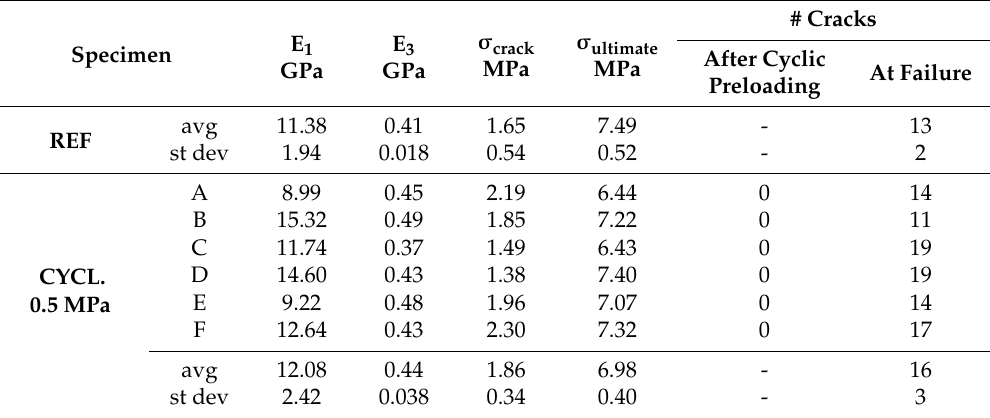
Table 6. Quantitative comparison of some distinctive parameters of the static tensile stress–strain curve: the average reference versus the specimens cyclically preloaded to 0.5 MPa. Specimen